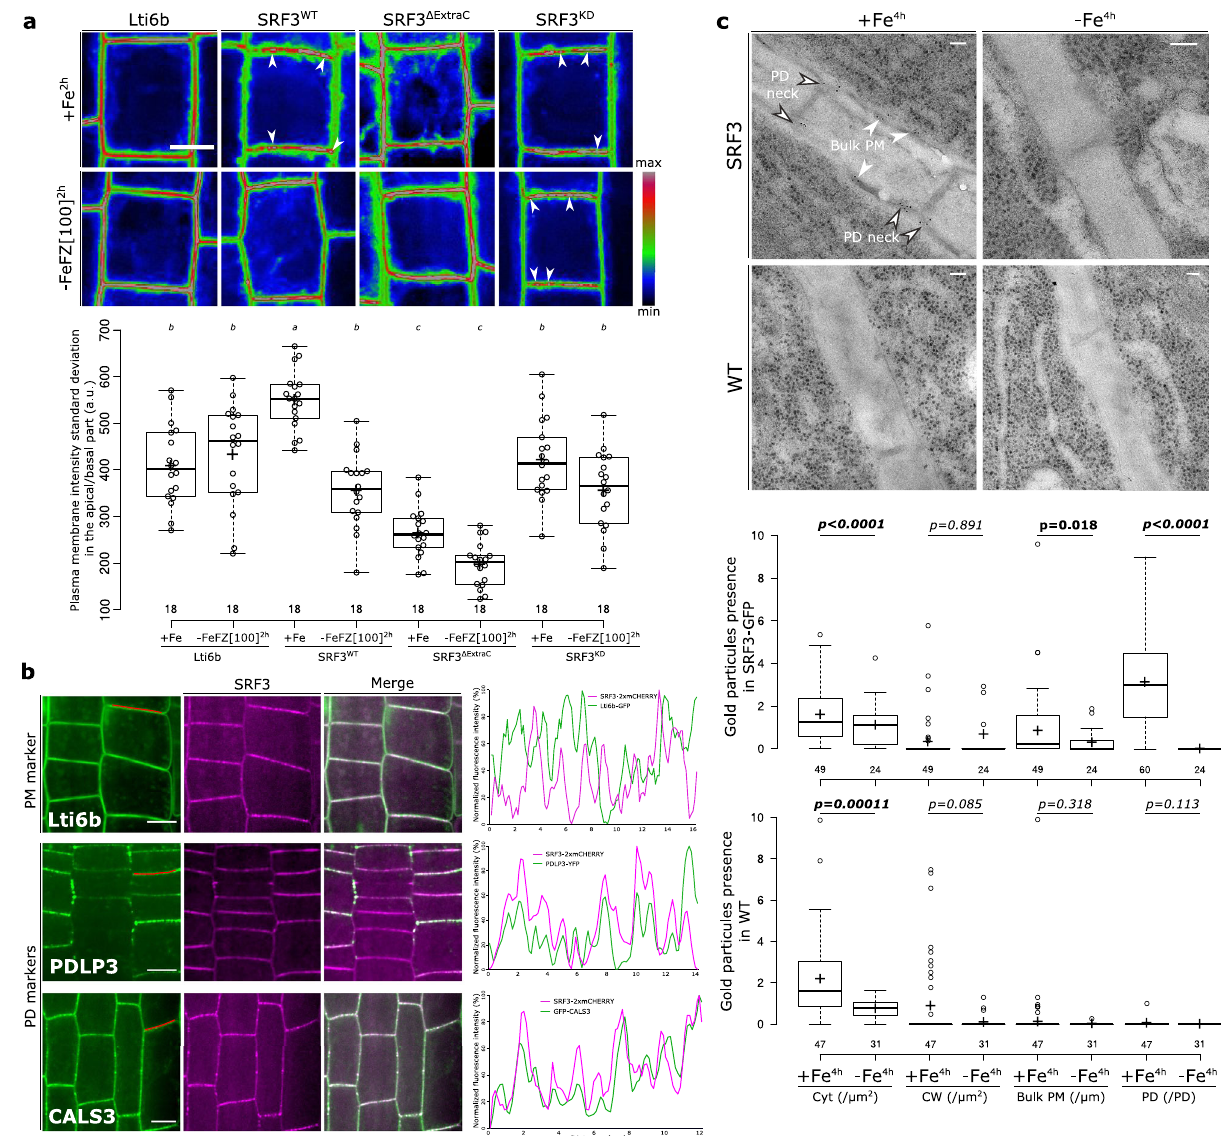
Fig. 3 | SRF3 co-exists in two sub-populations at the plasma membrane, which decrease under low iron levels. a Confocal images of root epidermal cells of 5 day old seedlings expressing p35s::eGFP-Lti6b , pUBQ10::SRF3-mCITRINE, pUBQ10::SRF3 WT -mCITRINE , pUBQ10::SRF3 Δ ExtraC -mCITRINE, pUBQ10::SRF3 KD -mCI- TRINE underironsuf fi cient(+Fe,2h)orlowiron( – FeFZ100 μ M,2h)conditionsand the related quanti fi cation [ANOVA with post hoc Tukey test; Letters: statistical differences( p <0.05)].Notethatthepictureshavebeenpseudo-coloredinrainbow RGB and intensities are optimized to emphasize changes in plasma membrane polarity and localization in the punctuated foci. Arrows indicate punctuated structures. Scale bars, 10 μ m. b Confocal images of root epidermal cells in the transition-elongation of 5 day old seedlings co-expressing, p35s::eGFP-Lti6b,